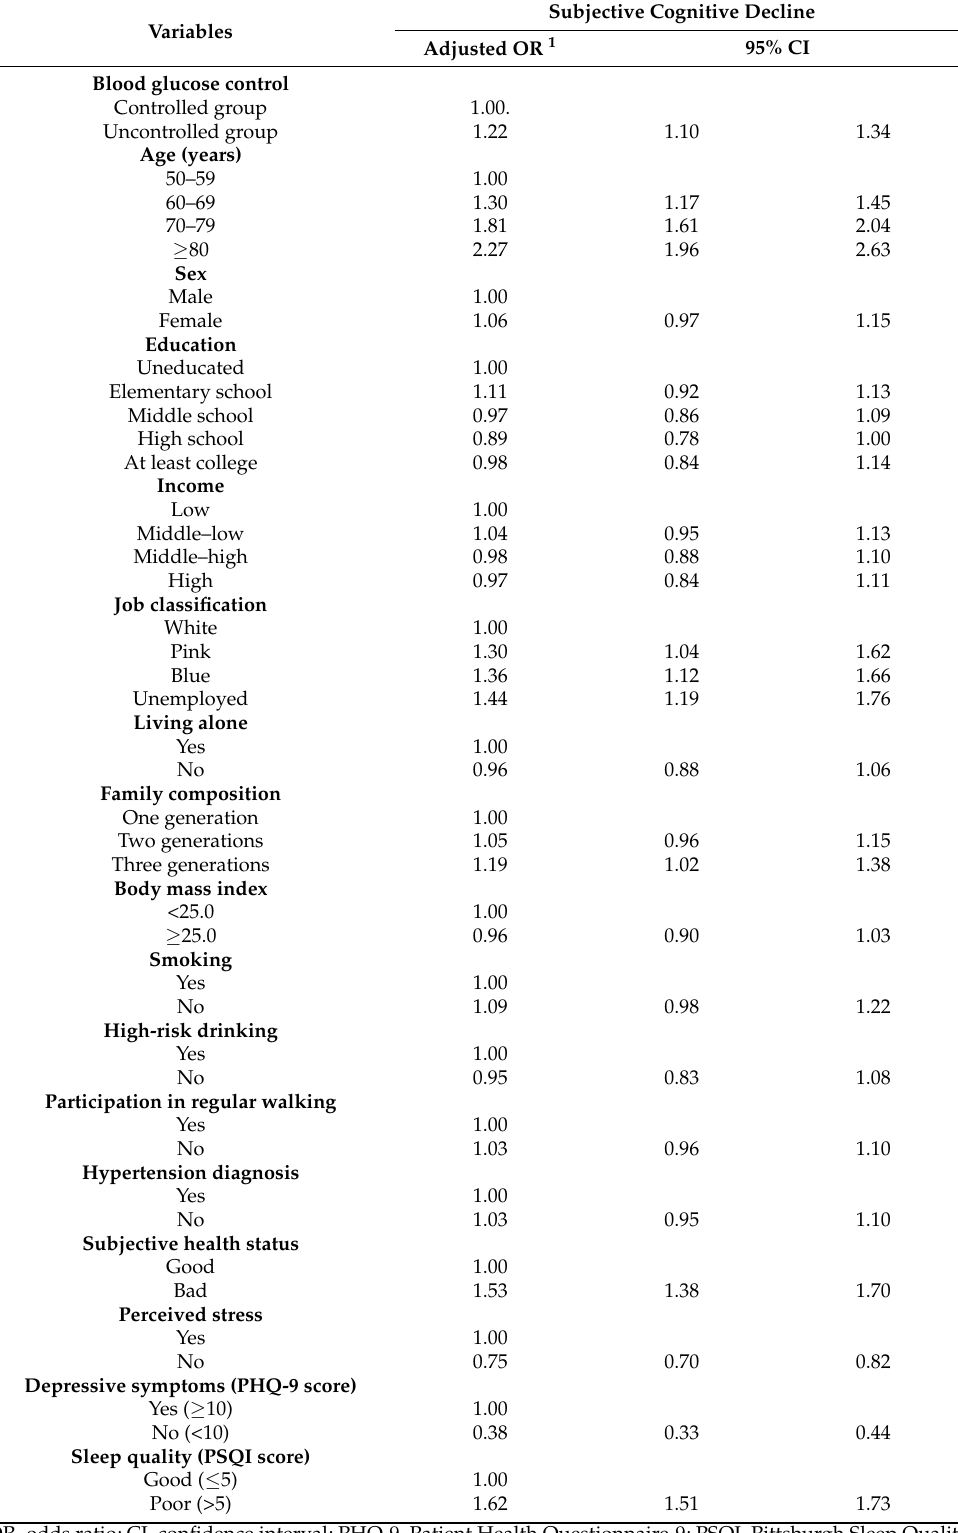
Table 3. Results of multivariable logistic regression analysis 1 of the association between blood glucose control and subjective cognitive